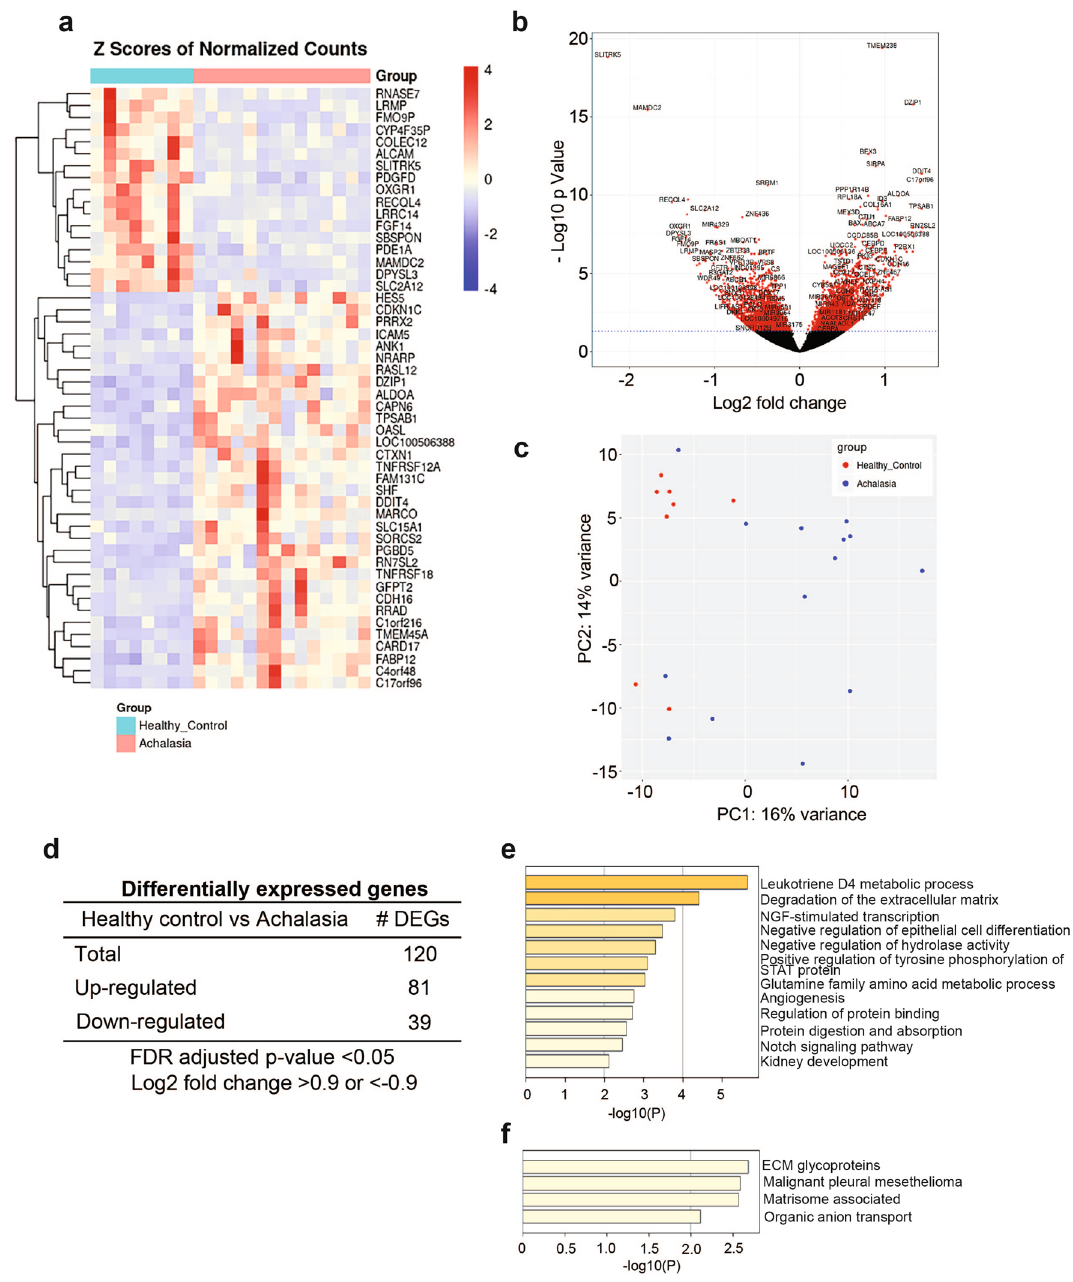
Figure 3. Comparison of differential gene expression analysis in proximal esophageal mucosa of achalasia. ( a ) DEGs in achalasia are shown in a heat map of RNA-seq expression data. ( b ) Volcano plot illustrating the log2 fold change in gene expression in achalasia subjects as well as the statistical significance. ( c ) Principal component analysis was performed using RNA-seq gene expression profiles of achalasia. Red = healthy control, blue = achalasia. ( d ) Differentially expressed genes were selected based on a log2 fold change of 0.9 and FDR < 0.05. ( e ) The heatmap shows the top up-regulated pathways. ( f ) The heatmap shows the top down- regulated